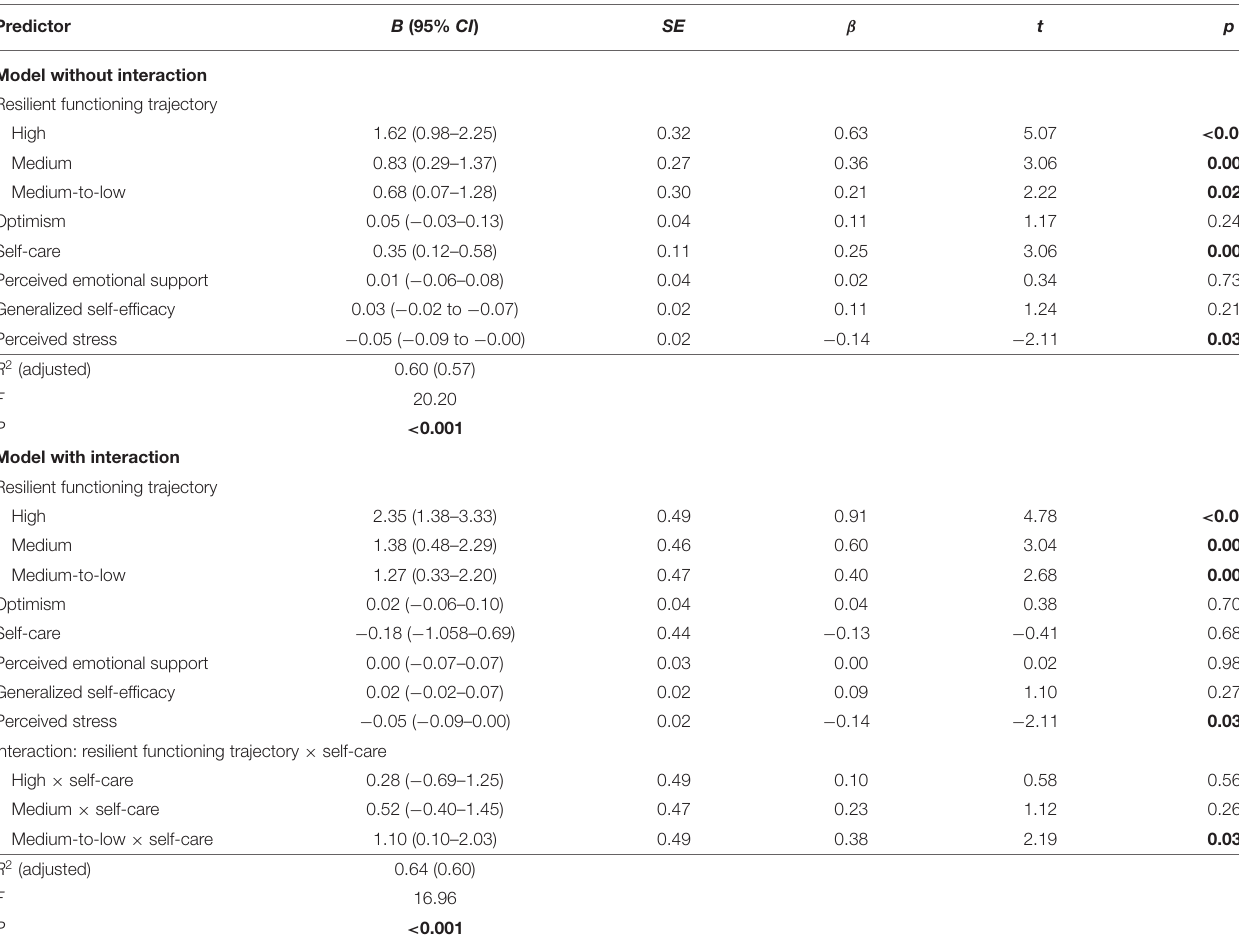
TABLE 4 | Multiple regression results showing predictors of resilient functioning during the lockdown.